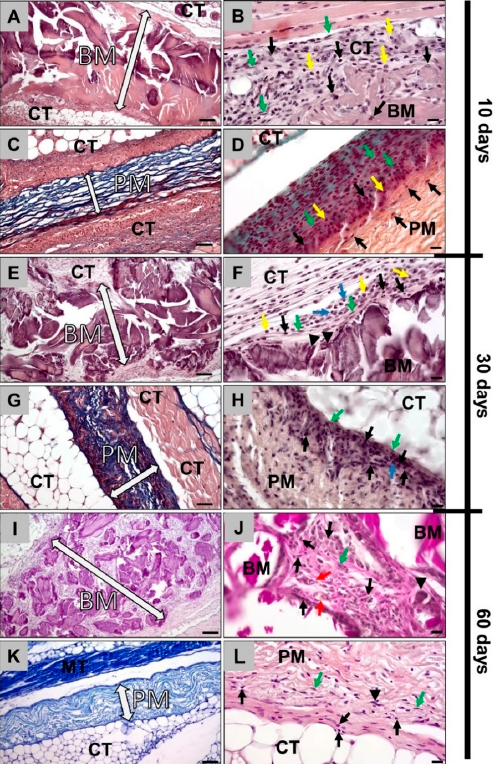
Figure 2. Histopathological images of bovine and porcine collagen membranes at days 10, 30 and 60. ( A ) Bovine collagen membrane at day 10 (hematoxylin and eosin (HE) staining, magnification = 200 × , scale bar = 50 µ m). ( B ) Bovine collagen membrane at day 10 (hematoxylin and eosin (HE) staining, magnification = 400 × , scale bar = 20 µ m). ( C ) Porcine collagen membrane at day 10 (Azan staining, magnification = 200 × , scale bar = 50 µ m). ( D ) Porcine collagen membrane at day 10 (Movat’s Pentachrome staining, magnification = 400 × , scale bar = 20 µ m). ( E ) Bovine collagen membrane at day 30 (hematoxylin and eosin (HE) staining, magnification = 200 × , scale bar: 50 µ m). ( F ) Bovine collagen membrane at day 30 (hematoxylin and eosin (HE) staining, magnification= 400 × , scale bar = 20 µ m). ( G ) Porcine collagen membrane at day 30 (Azan staining, magnification = 200 × , scale bar = 50 µ m). ( H ) Porcine collagen membrane at day 30 (hematoxylin and eosin (HE) staining, magnification = 400 × , scale bar = 20 µ m). ( I ) Bovine collagen membrane at day 60 (hematoxylin and eosin (HE) staining, magnification = 200 × , scale bar = 50 µ m). ( J ) Bovine collagen membrane at day 60 (hematoxylin and eosin (HE) staining, magnification = 400 × , scale bar= 20 µ m). ( K ) Porcine collagen membrane at day 60 (Giemsa staining, magnification = 200 × , scale bar= 50 µ m). ( L ) Porcine collagen membrane at day 60 (hematoxylin and eosin (HE) staining, magnification= 400 × , scale bar = 20 µ m). BM: bovine membrane; PM: porcine membrane; MT: muscle tissue; CT: connective tissue; white arrow: borders of the membrane; black arrows: macrophages; green arrows: fibroblasts; yellow arrows: eosinophils; blue arrows: neutrophils; black arrowheads: multinucleated giant cells; red arrows: blood